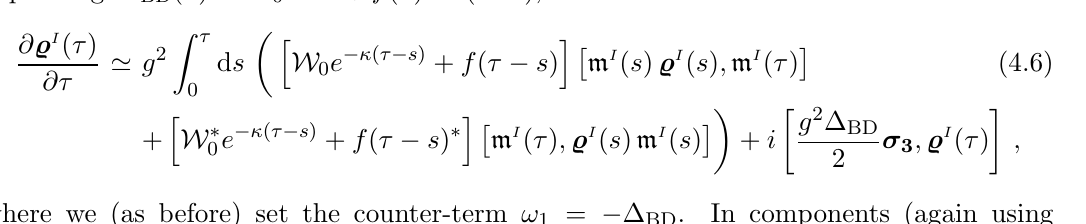
The (cid:12)rst step is to rewrite the Nakajima-Zwanzig equation in terms of f ( (cid:28) ) by